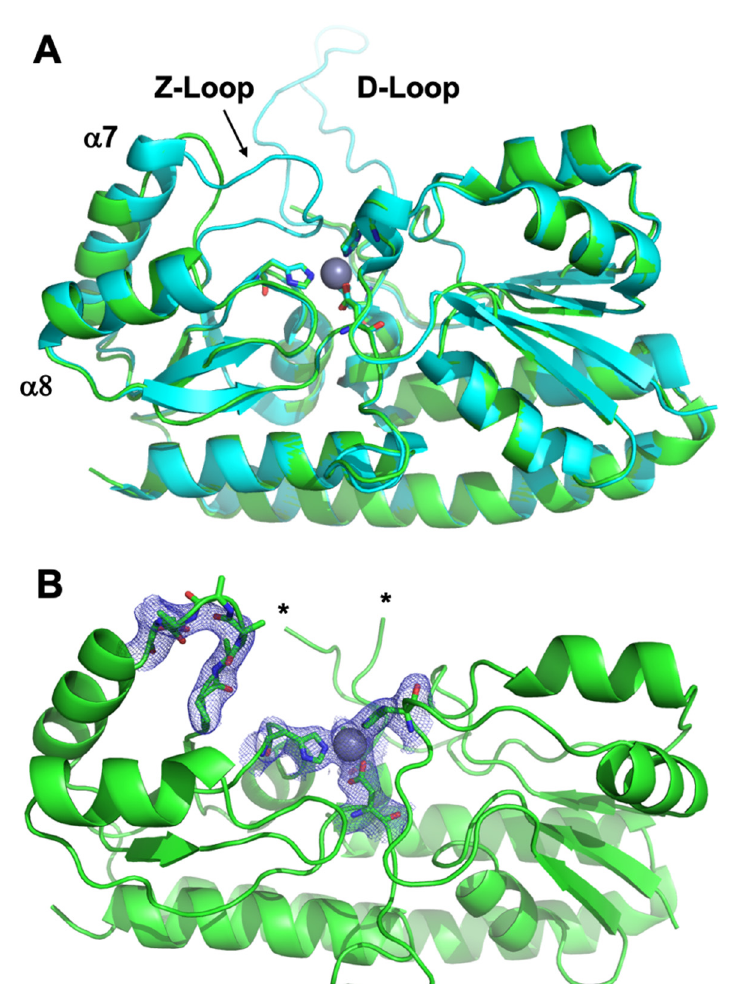
Figure 6. Crystal structure of ∆ Z-Loop AztC. ( A ) Overlay of ∆ Z-Loop (green) and WT (blue) AztC. Zinc binding residues are shown as sticks colored according to element and zinc is shown as a gray sphere. ( B ) ∆ Z-Loop AztC showing 2Fo–Fc electron density contoured at 1.0 σ for the truncated loop and zinc binding site. Asterisks indicate residues 116 and 134 between which residues could not be modeled due to a lack of electron density.